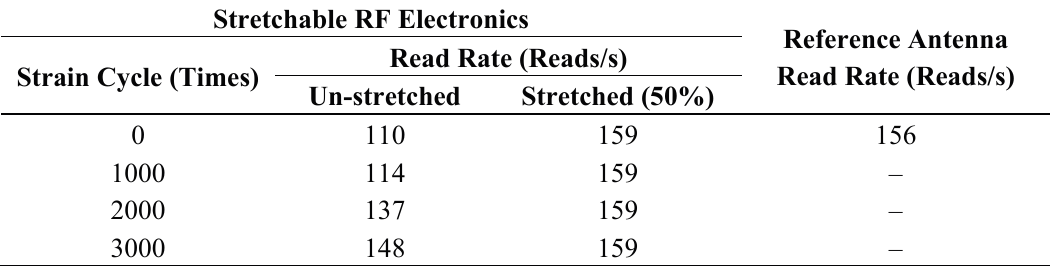
Table 1. Performance of the stretchable RF electronics with strain and